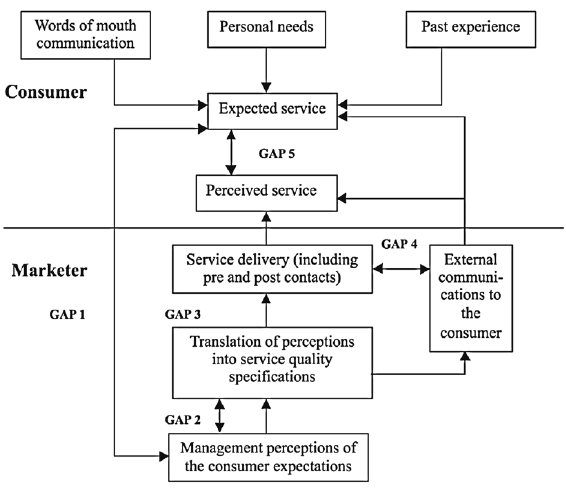
Figure 6. Servqual